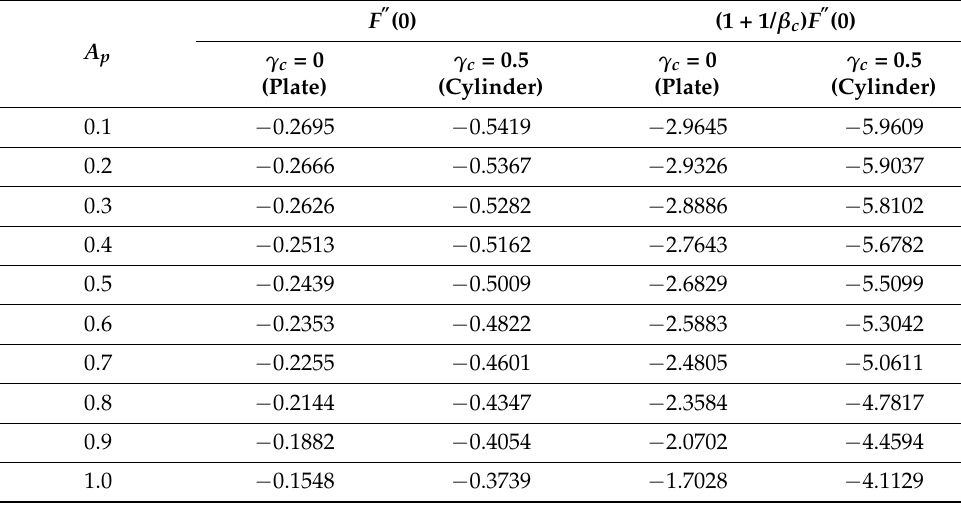
Table 4. Variation in SFC for A p when M p = 0.